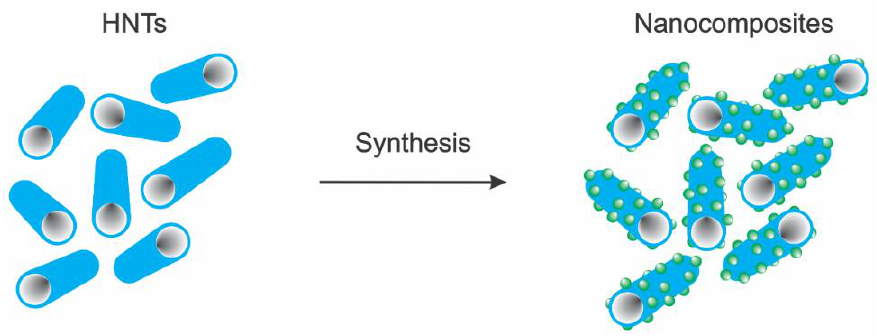
Figure 4. Schematic representation of halloysite-based nanocomposites.